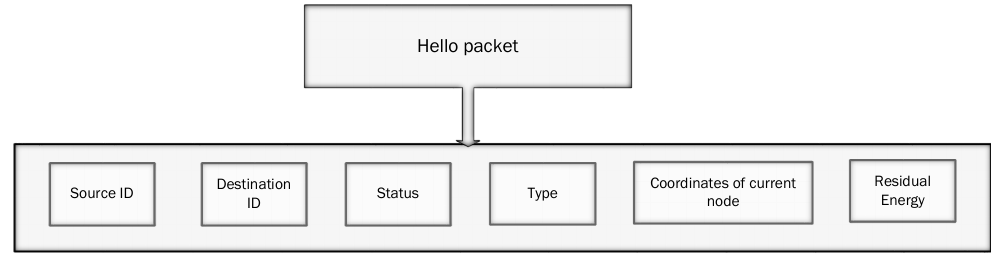
Figure 5. Structure of hello